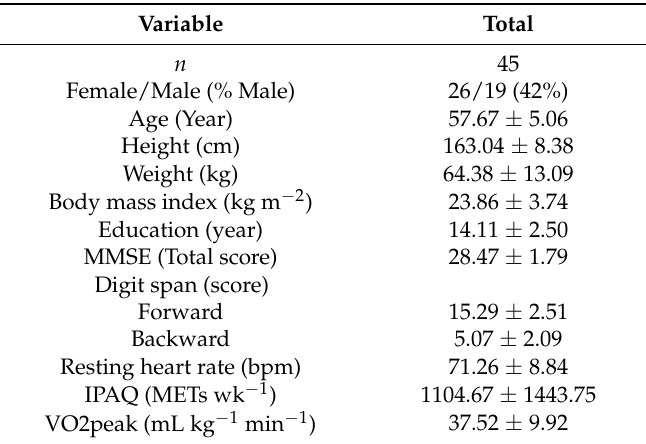
Table 1. Demographic characteristics for participants (mean ±